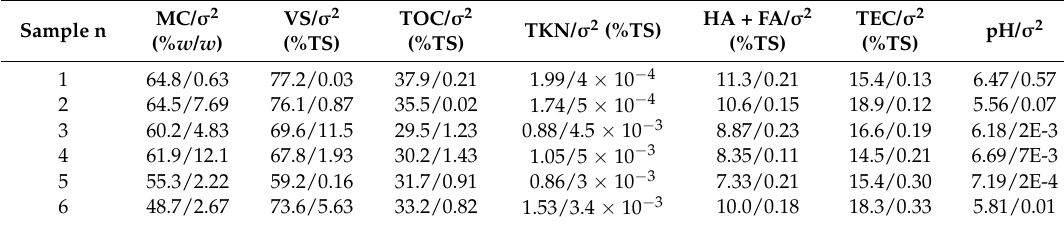
Table 4. Organic carbon, nitrogen, humic acids (HA) + fulvic acids (FA) and total extractable carbon (TEC) for six samples of the organic fraction of municipal solid waste (OFMSW) with related variances ( σ 2 ). Sample